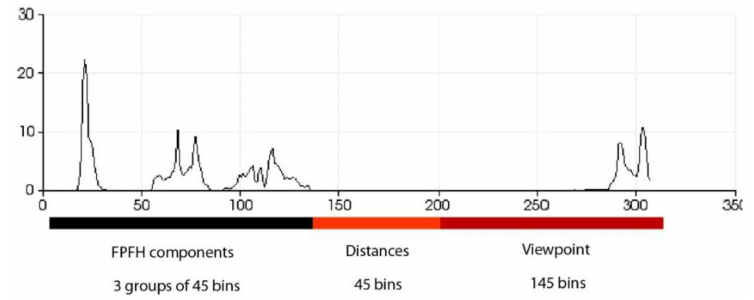
Figure 8. Description of the zones of the